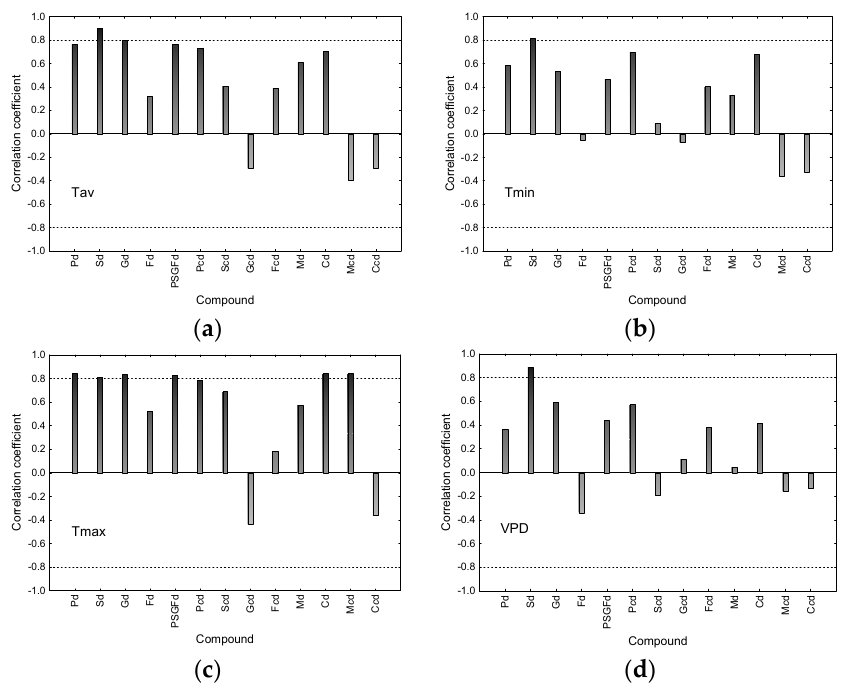
Figure 5. Pearson correlation coefficients were calculated between T av —average ( a ); T min —minimum ( b ); T max —maximum ( c ) temperatures and vapor pressure deficit (VPD) ( d ) versus δ 13 C for pinitol (P), sucrose (S), glucose (G), fructose (F), total carbohydrates (PSGF) and their concentrations Pc, Sc, Gc, Fc, and organic acid compounds ( δ 13 C in malate (M), citrate (C) and their concentrations Mc, Cc) in declining mountain pines. Horizontal black lines on the top and bottom present significance levels of p < 0.05.